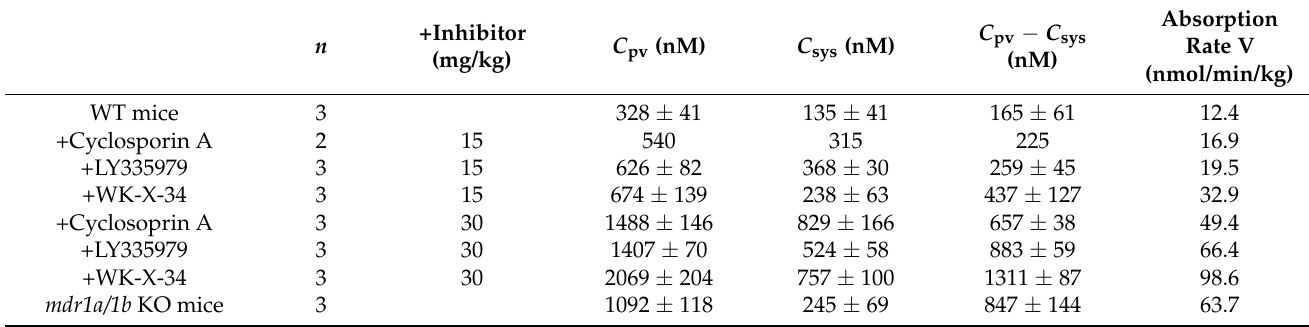
Table 5. Absorption rate of paclitaxel (10 mg/kg) at 30 min after its oral administration with or without P-gp inhibitor in WT and mdr1a/1b KO